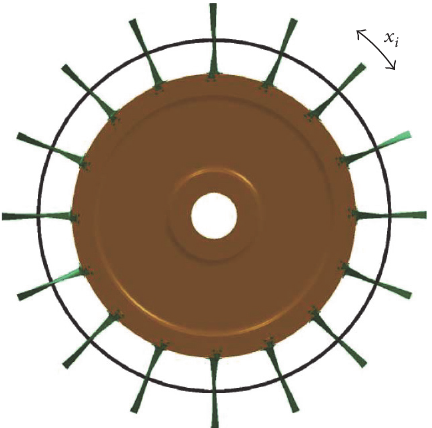
Figure 1: The 3D model of